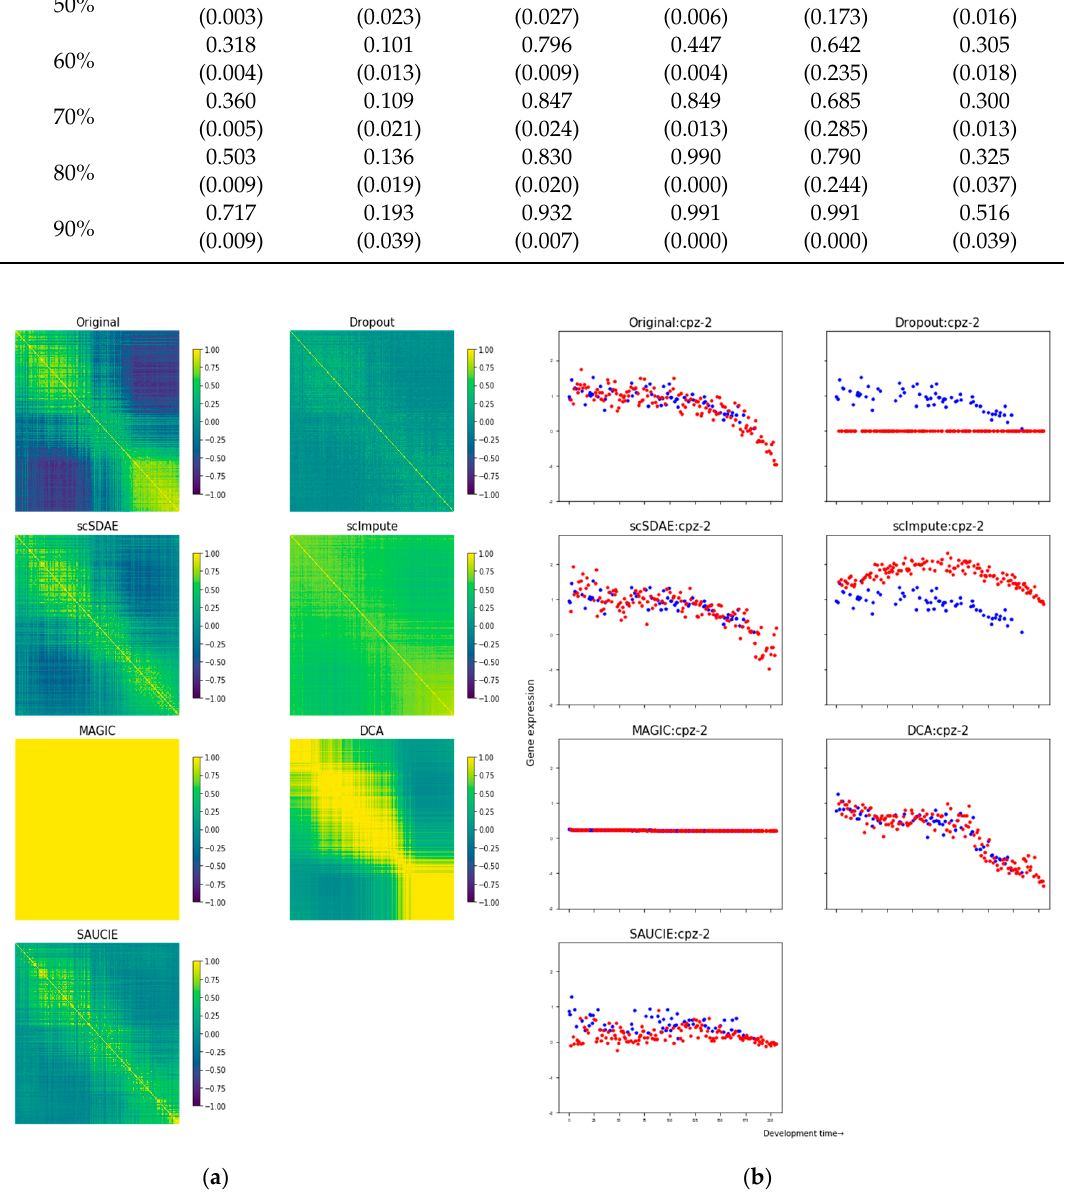
Figure 2. Performance comparison of simulated data. ( a ) The heatmaps of sample-to-sample correlation matrices show scSDAE best recovered sample developmental trajectory affected by simulated missing values. The samples are ordered by developmental time. So as is shown in the original data and scSDAE, the correlations around diagonal should be high, but correlations o ff the diagonal should not. ( b ) Scatter plots of gene expression trajectory show that scSDAE best recovered gene expression a ff ected by simulated missing values for gene cpz-2 . Scatter plots of the expression trajectory of randomly selected gene cpz-2 from the original bulk data, simulated missing data, and expression data imputed after di ff erent imputation methods are shown. The horizontal axis represents the development time of the samples. The vertical axis stands for the gene expression value. Each point represents a sample. The red points represent the values simulated to be zeros, and the blue ones represent the observed